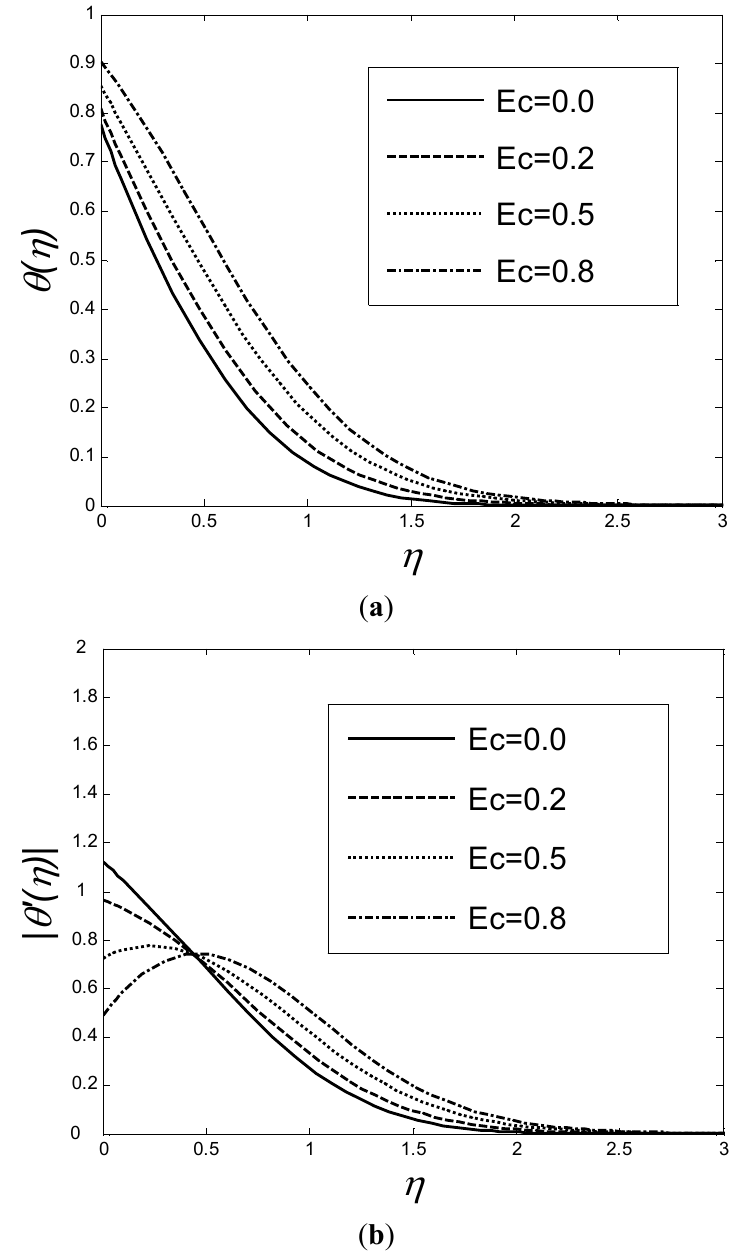
= 0.2, Pr = 7 and M = w